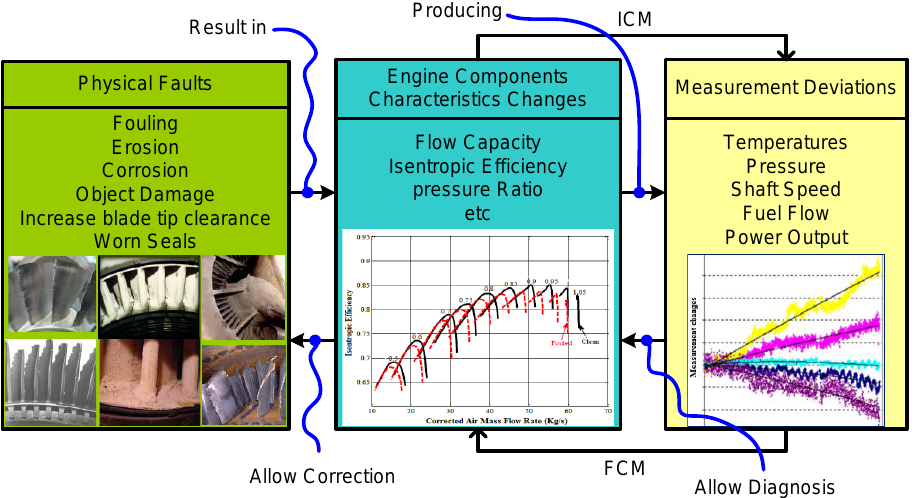
Figure 1. Gas turbine (GT) physical faults, components’ characteristics, and measurements (adapted from [16]). ICM: Influence coefficient matrix; FCM: Fault coefficient matrix.